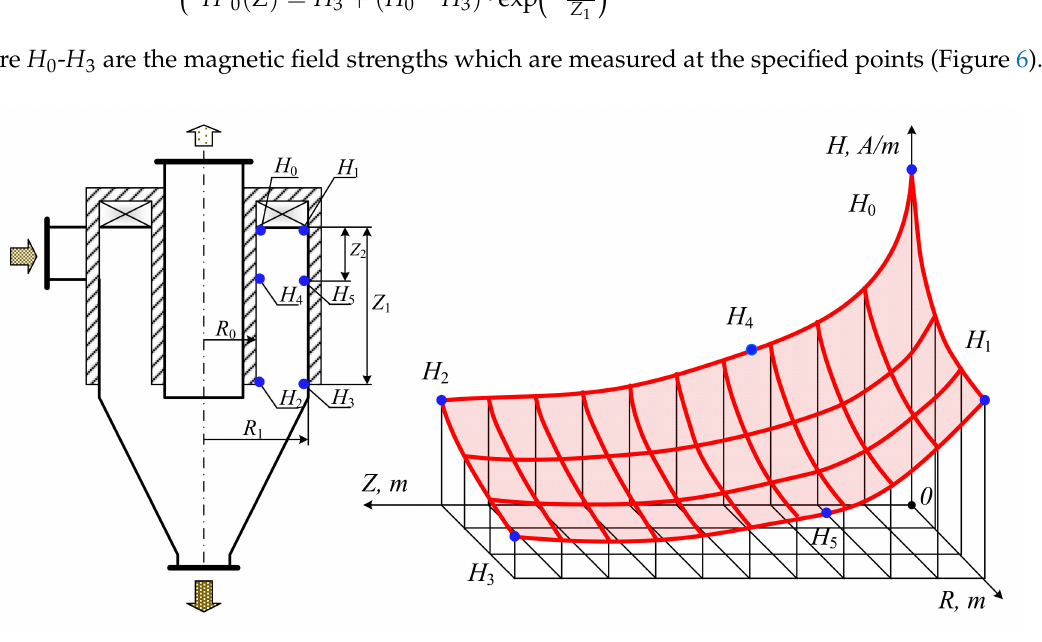
Figure 5. Change in magnetic field strength in height at various currents in the winding: ( а ) I = 10 А , n 1 = 5; ( b ) I = 40 А , n 1 = 6.